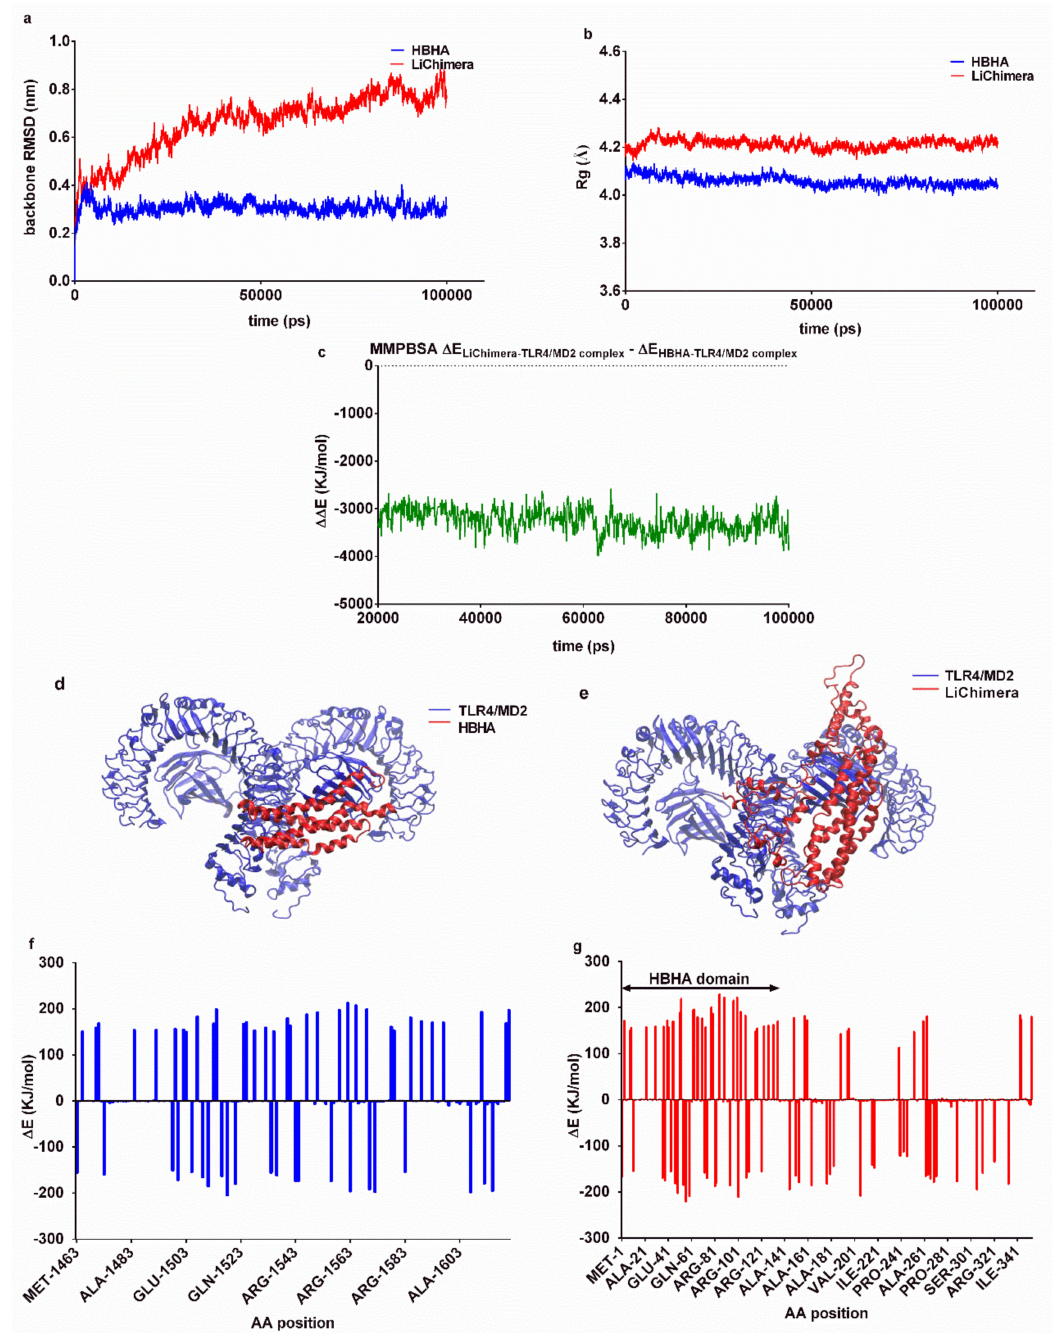
Figure 2. Molecular dynamics of HBHA and LiChimera complexes bound on TLR4 / MD2. ( a ) RMSD changes of backbone atoms as compared with the starting structure of ( a ) HBHA and LiChimera complex; ( b ) Radius of gyration (R g ) of HBHA-TLR4 / MD2 and LiChimera-TLR4 / MD2 complex during the trajectories indicated that the predicted docking solutions retained their compactness; ( c ) Di ff erence of MMPBSA calculated binding energies between LiChimera and HBHA during the course of the simulations; Backbone representation of ( d ) HBHA-TLR4 / MD2 and ( e ) LiChimera-TLR4 / MD2 complex; Residue contribution on MMPBSA binding energies of ( f ) HBHA and ( g ) LiChimera on TLR4 / MD2